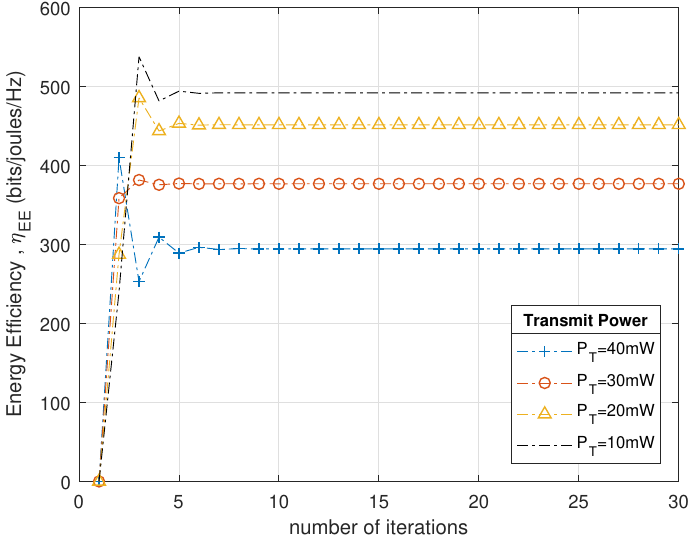
Figure 9. EE with respect to transmit